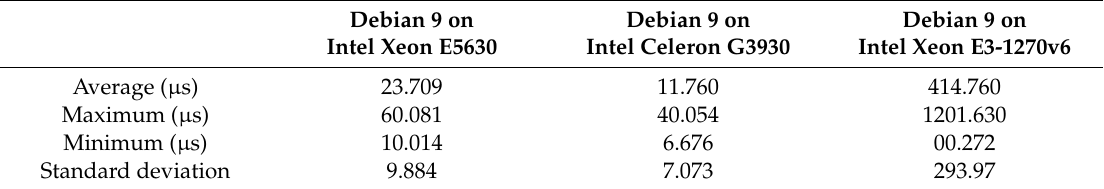
Table 1. Results of environment variable value change